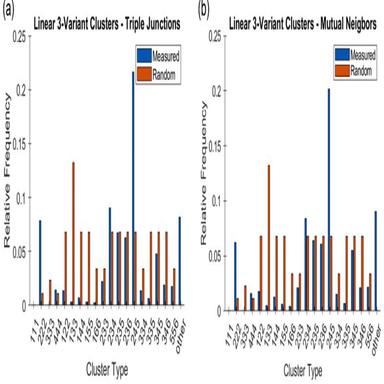
The results of the 3-variant cluster analysis (a) as performed using the triple junction algorithm a)) and (b) as performed using the mutual neighbors algorithm (b)). The results compare the measured frequencies of the different possible groups of intervariant boundaries to the probability of those groups occurring in the absence of variant selection.